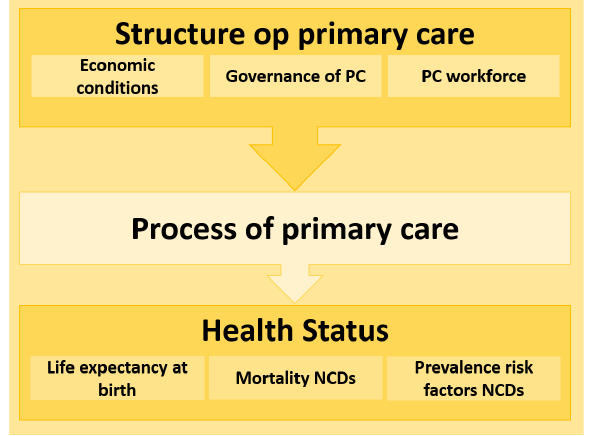
Figure 1 . Dimensions and sub-dimensions used during this literature